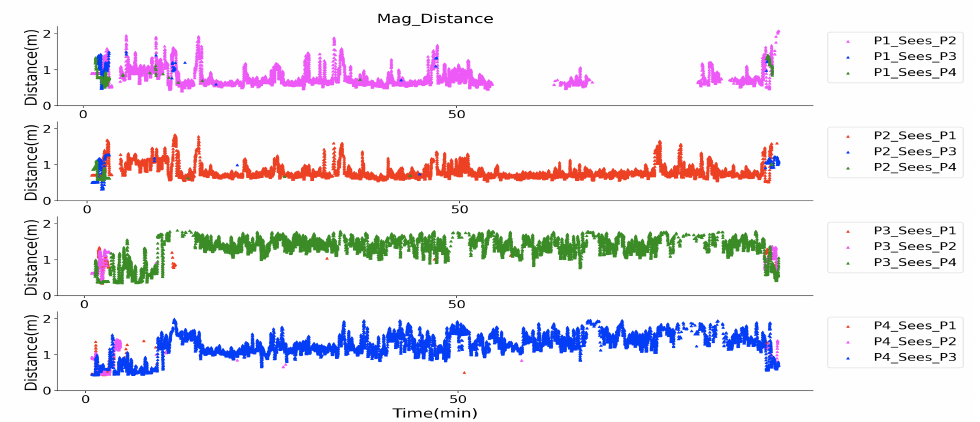
Figure 25. Distance deduced by our prototype during the city-walk where P1 and P2 as one group with a distance of 1.0 m and P3 and P4 as another group with a distance of around 1.5 m, and the distance between the two groups is beyond 3.0 m.